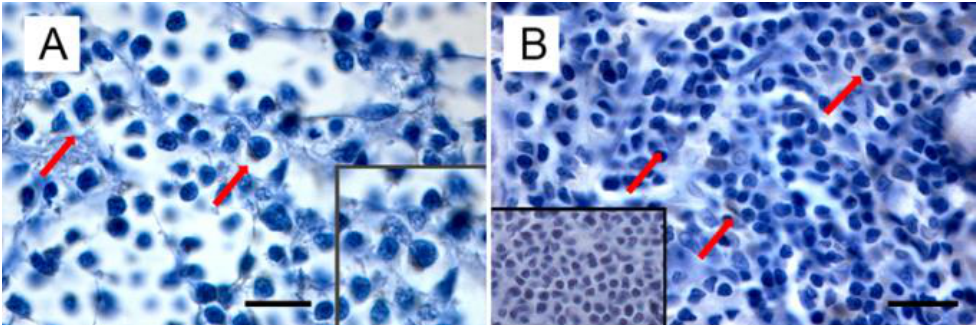
Figure 3. Immunohistochemical expression of p14 in MMTVels-positive feline lymphoma: ( A ) nasal B-cell lymphoma. Diffuse cytoplasmic expression of p14 in tumoral lymphoblasts (arrows). Neoplastic cells show severe anisokaryosis, anisocytosis, and reticulate chromatin. Insert: high magnification of P14-positive lymphoblast. (IHC, bar = 100 μ m); ( B ) gastrointestinal T-cell lymphoma. Scattered cytoplasmic expression of p14 in neoplastic lymphoblasts (arrows). Tumoral cells show marked anisokaryiosis and anisocytosis, indented nuclei with marginated chromatin, and prominent nucleoli. Insert: negative control. Absence of cytoplasmic staining in neoplastic lymphoblast. (IHC, bar = 50 μ m). The IHC was performed by incubating slides with 1:2000-diluted rabbit polyclonal antibody against MMTV-p14 (kindly provided by Dr J. Hochman, University of Jerusalem, Israel) for 2 h at room temperature and following the Labeled Streptavidin Biotin method.